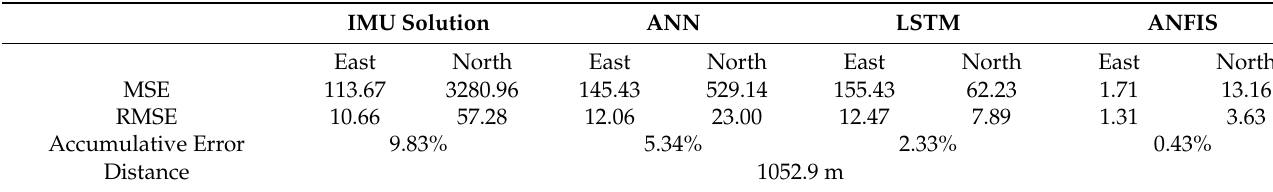
Table 4. Error statistics of three algorithms in the n system.